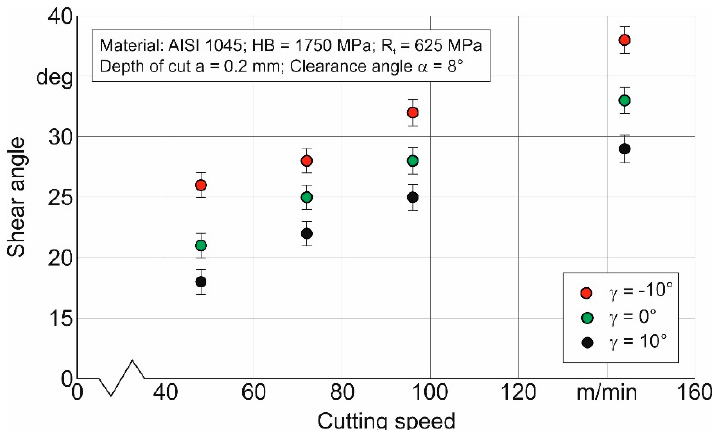
Figure 6. Changing the shear angle depending on the cutting speed and the tool rake angle.